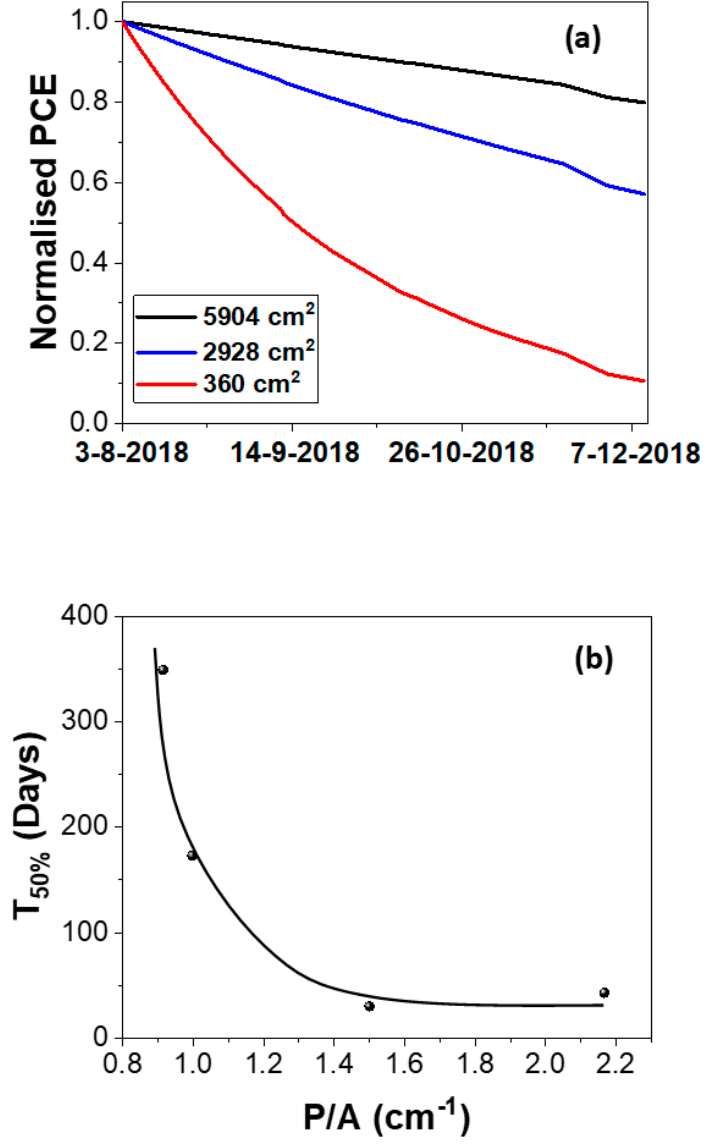
Figure 3. ( a ) Degradation curves of modules tested outdoors over the course of 4 months at a fixed irradiance of 300 ± 10 Wm − 2 ; fitted degradation trend lines shown, and ( b ) variation in time to reach 50% of the original efficiency (T 50% lifetime) as a function of the Perimeter-to-area ratio (P/A)